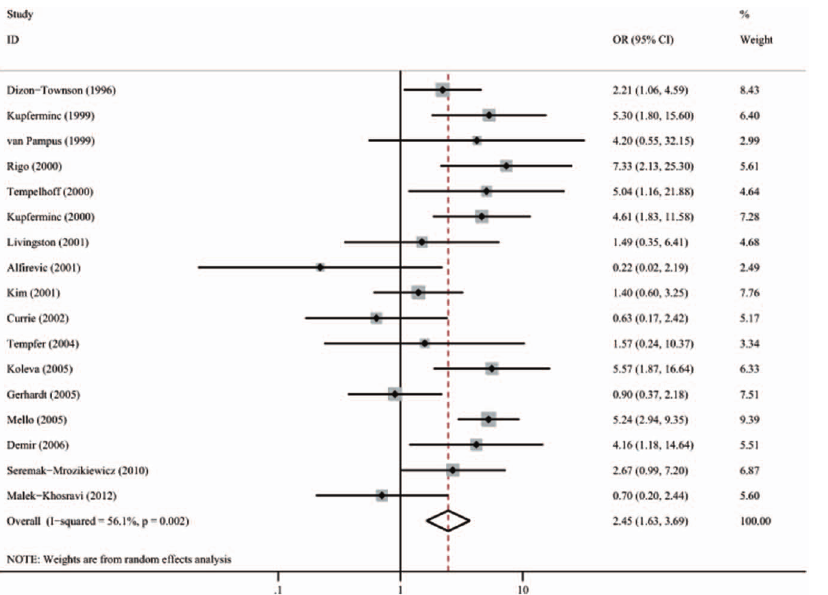
Figure 8. Forest plots of OR with 95%CI of severe preeclampsia associated with FVL in random model. Black square means value of OR, and the size of the square means inversely proportional to its variance. Horizontal line means 95% confience interval (CI) of OR. Black diamond means pooled results.